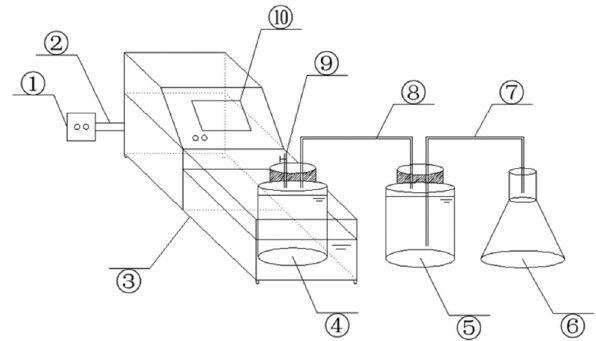
Figure 1: Anaerobic digestion reaction device for cattle manure in sub - mesophilic temperatures. ( 1 ) Controller, ( 2 ) heating rod, ( 3 ) water bath, ( 4 ) anaerobic digestion reactor, ( 5 ) collecting gas bottle, ( 6 ) collecting water bottle, ( 7 ) outlet pipe, ( 8 ) airway, ( 9 ) sampling place, and ( 10 ) temperature monitor.